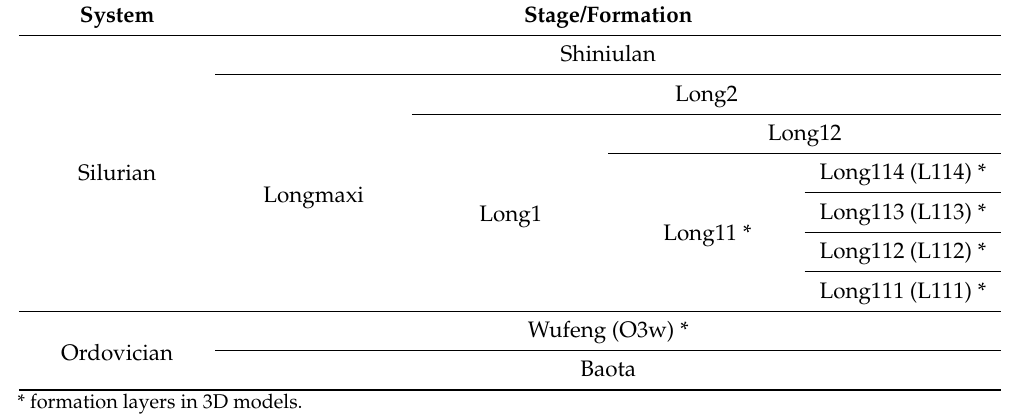
Table 1. Stratigraphic column table in the study area.